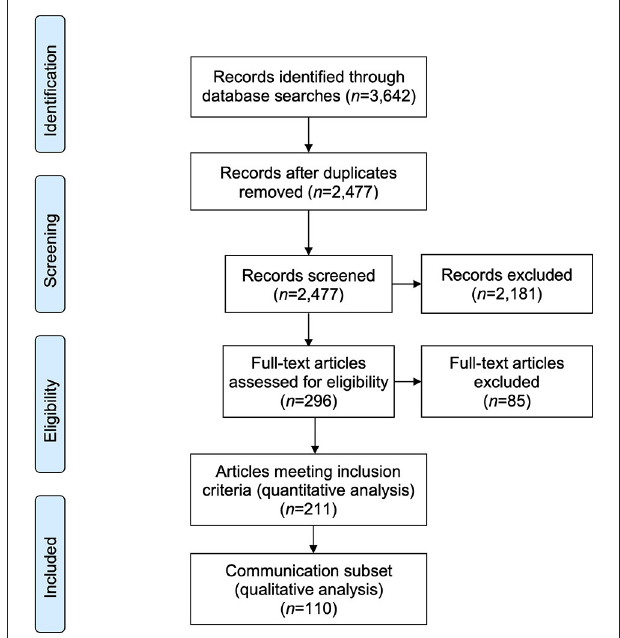
FIGURE 1 | PRISMA flow: Article selection